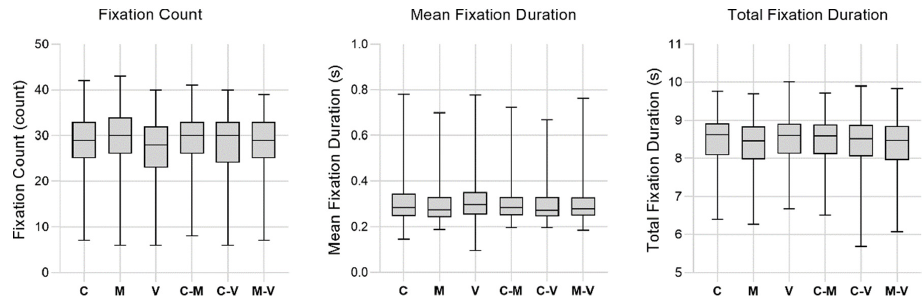
Figure 6. Boxplots of fixation count, mean fixation duration, and total fixation duration. Table 5. Spearman’s correlation coefficients for aesthetic preference ratings and eye-tracking data.